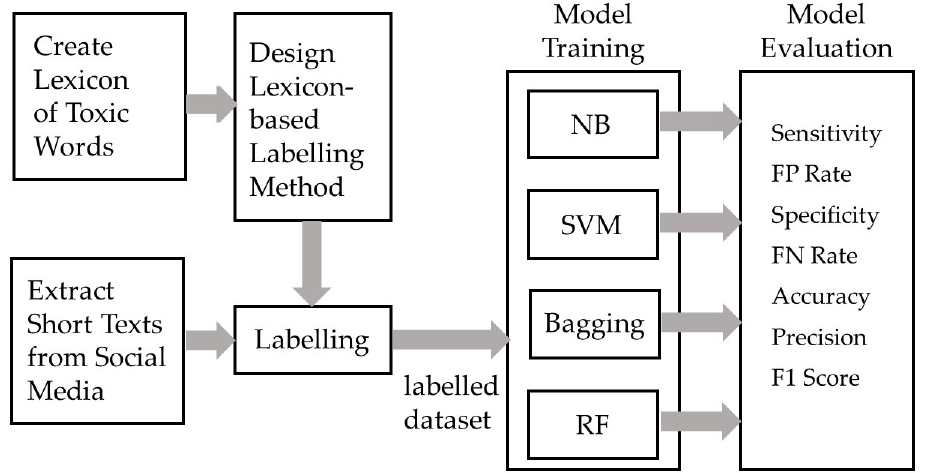
Figure 5. Methodology of research devoted to the creation of the detection models for detection of a degree of toxicity in social media.